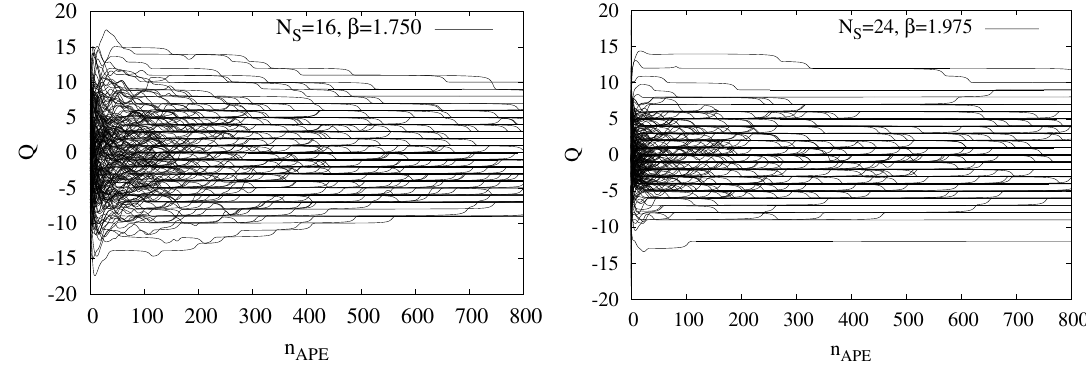
Figure 1 . Smearing history of topological charge Q as a function of the number of smearing steps n APE for randomly chosen 200 configurations at β = 1 . 750 and